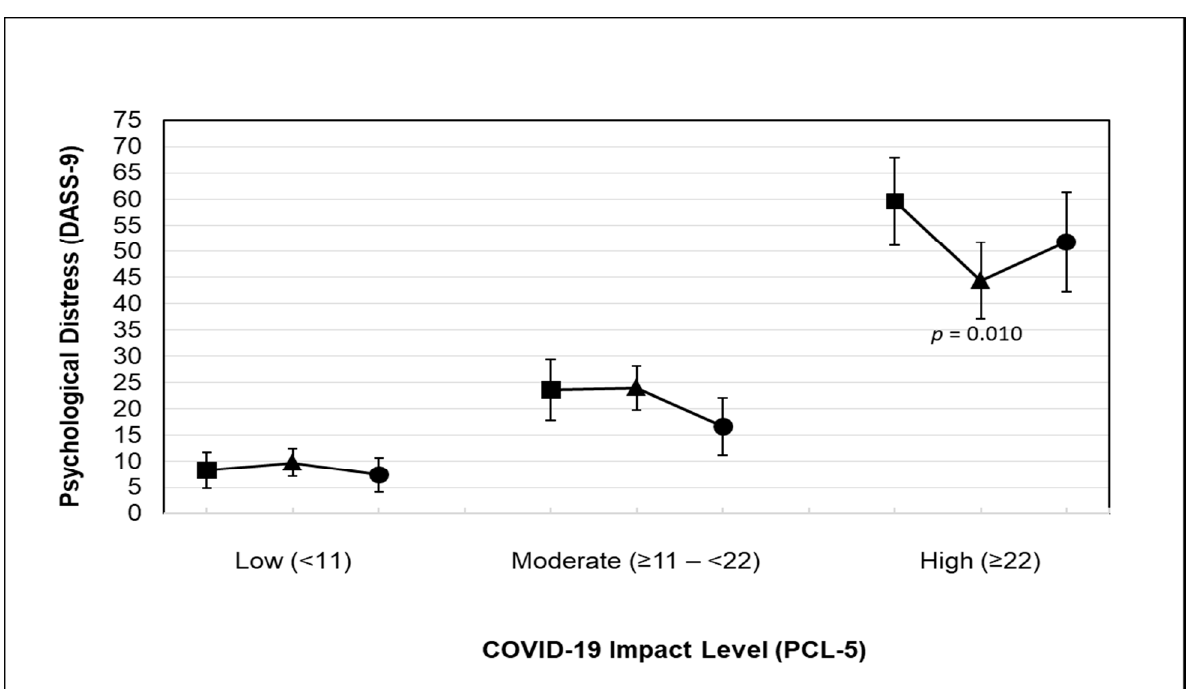
Figure 2. Predicted marginal mean psychological distress for COVID-19 impact among adults participating in physical activity (( (cid:4) Inactive: reporting <600 MET-min/week), ( (cid:78) sufficiently active: reporting ≥ 600 MET-min/week), and ( • very active: reporting ≥ 3000 MET-min/week)). The model was adjusted for age, sex, body mass index, ethnicity, region of residence, social status, education, employment, income, smoking status, and chronic diseases. Abbreviations: CI, confidence interval; DASS-9, Depression, Anxiety, and Stress Scale; PCL-5, posttraumatic stress disorder checklist.